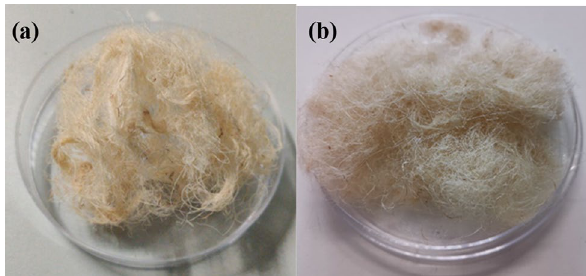
Figure 1. Representative samples of the raw ( a ) and treated cellulose fiber with the chemical softener TTAB ( b